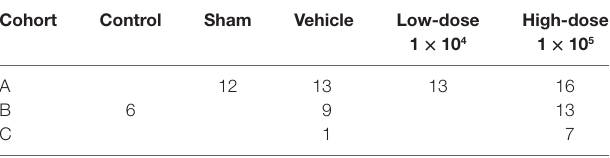
Table 1 | Numbers of mice used in the experiments.